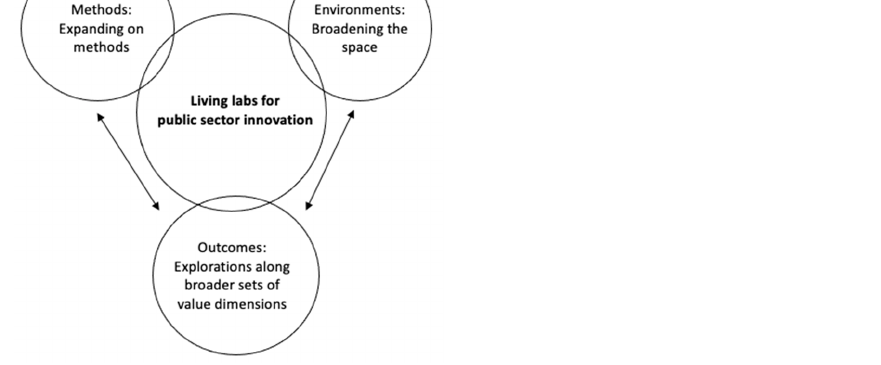
Figure 2. Model conceptualizing how living labs provide new foundations for public sector